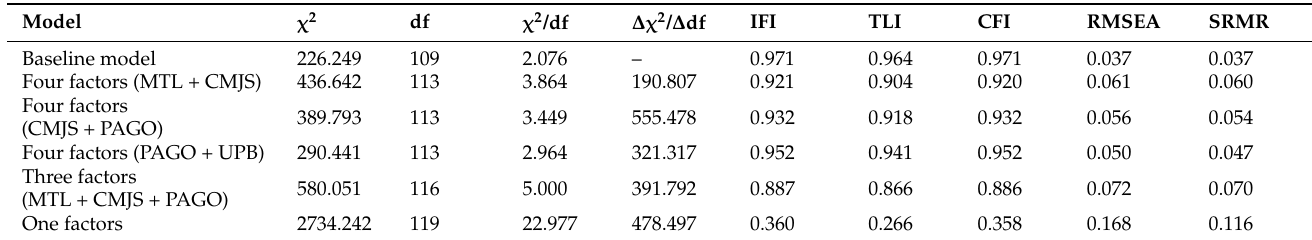
Table 1. Comparison of Measurement Models.